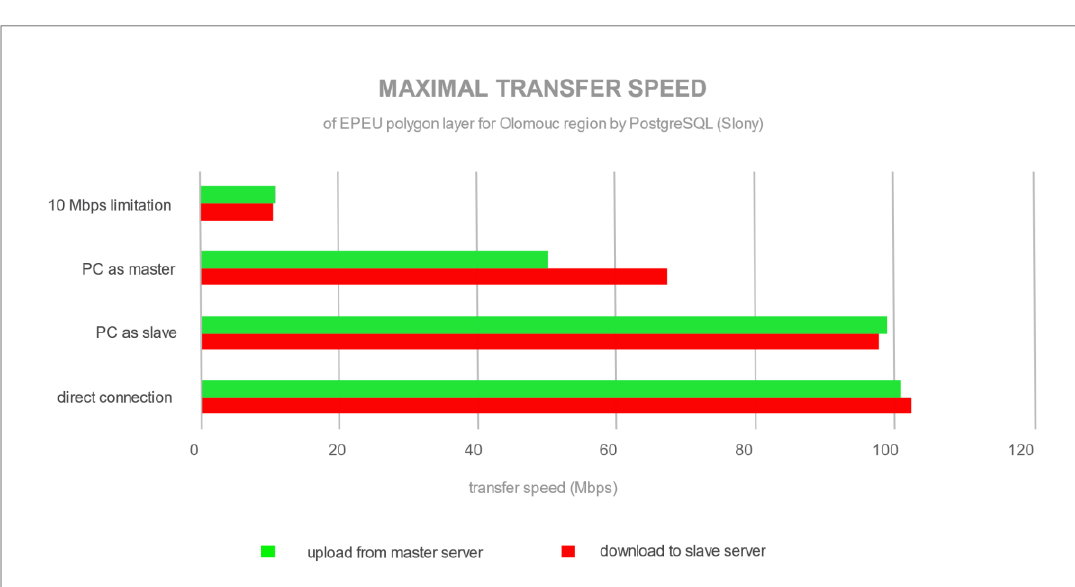
Figure 7. Average replication speed of the EPEU layer for different cluster configurations by PostgreSQL (Slony).